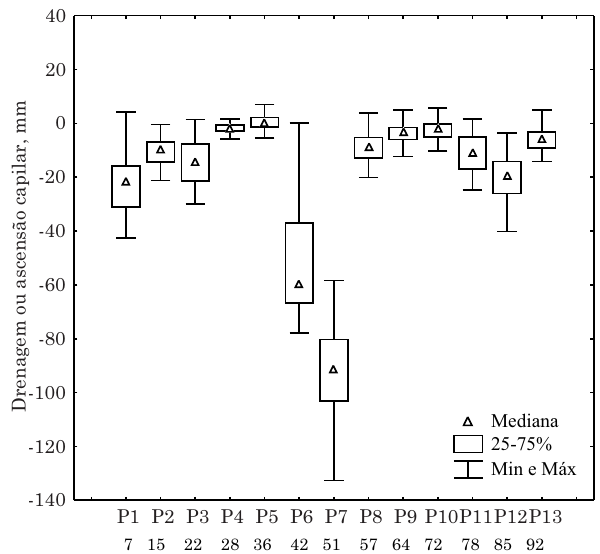
Figura 2. Drenagem ou ascensão capilar observada para os 13 períodos, em dias julianos, após a eliminação dos dados